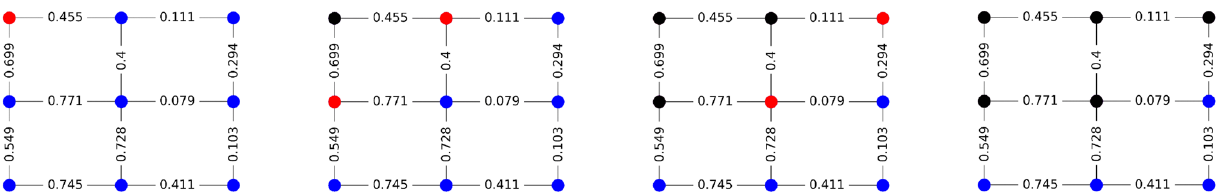
Figure 1. An exemplary random sequence (top-left to top-right to bottom-left to bottom-right) of the Independent Cascade Model (ICM) dynamics over 3 × 3 grid. Nodes colored red, blue, and black are I nfected, S usceptible, and R emoved at the respective stage of the dynamical process. This (shown) sample of the dynamic process terminates in 3 steps. Ising Model of Pandemic (IMP), which is the focal point of this manuscript, describes a regularized version of the ICM terminal state, where only two states ( S —blue and R —black) are left. (See text for